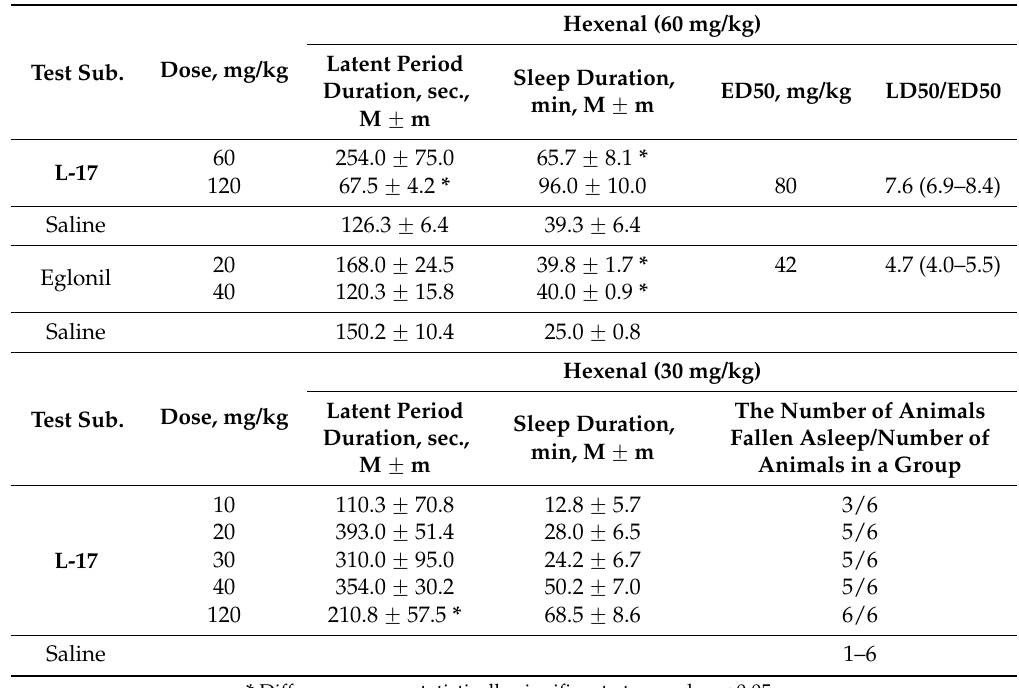
Table 5. Results of the hexenal